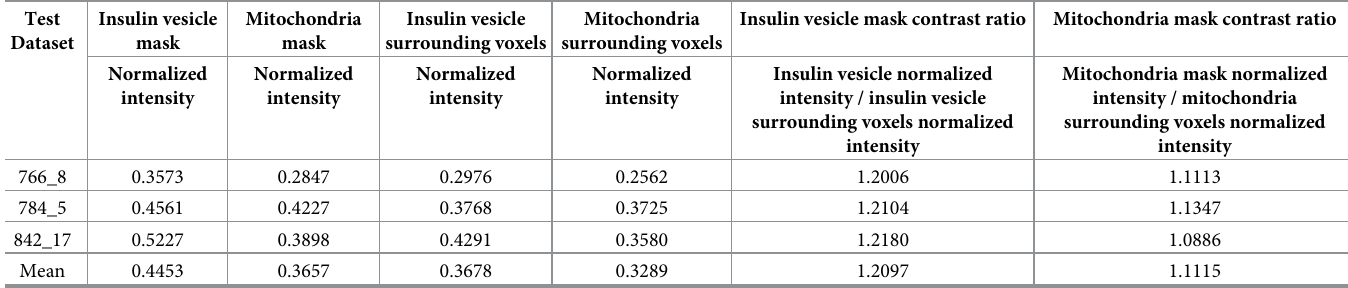
Table 2. Linear absorption coefficient (LAC) value and normalized intensity of insulin vesicle and mitochondria masks in the three test datasets from the manual segmentation results. Test Insulin vesicle Dataset mask